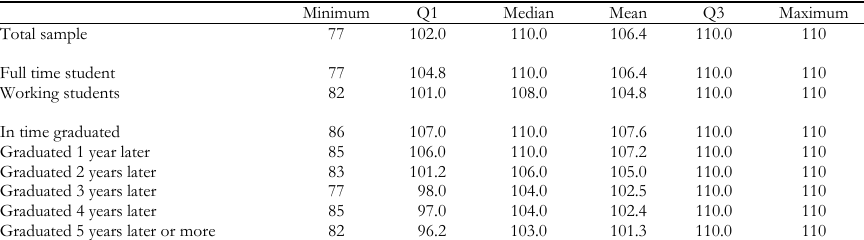
Descriptive statistics of the degree